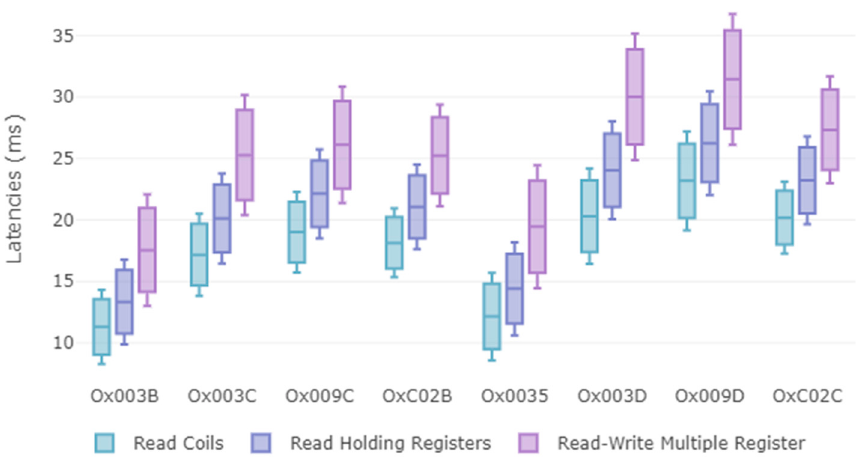
Figure 13. Boxplot (maximum, average, minimum) of latencies (ms) for each of the cipher suites when applying RBAC model.